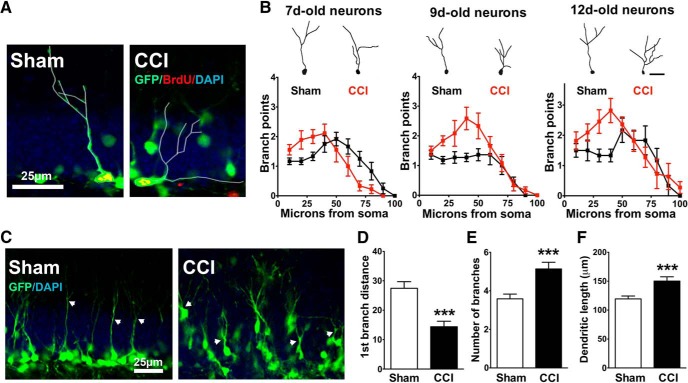
Granule cells born after CCI have accelerated dendritic growth. A, Confocal image of BrdU+ cells expressing GFP in POMC-EGFP mice, used to precisely date the birth of cells for morphologic analysis. In this example, BrdU was administered to POMC-EGFP mice 5 d after CCI or sham procedure and perfusion was fixed at 14 d, so that BrdU+ cells were 9 d postmitosis. Traced cells are outlined in white. B, Representative images (top) of dendritic tracings of 7-, 9-, and 12-d-old GFP+ cells in sham and CCI-treated mice, and the Sholl analyses (bottom) for group data at each time point. In each cohort, CCI increased the number of dendritic branch points of immature cells born during post-traumatic neurogenesis (p = 0.002713). Branches also occurred closer to the cell body in CCI-treated mice in each cohort, which was independent of cell age (p = 0.7615). C, Representative images of GFP+ cells and their dendritic outgrowth. White arrows point to the first dendritic branch points. D–F, GFP+ cells from CCI treated mice branched closer to their cell body (***p = 0.001216; D), had more cumulative branches (***p = 0.000517; E), and had greater total dendritic length (***p = 0.00118; F).